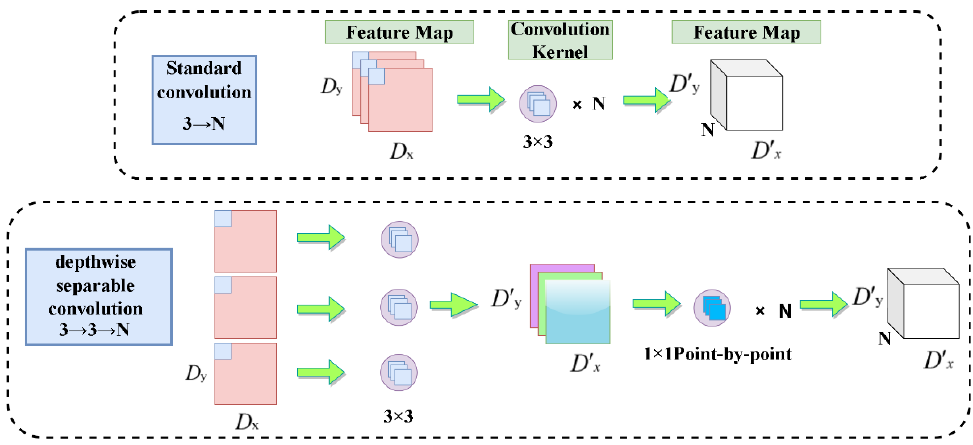
Figure 5. Comparison of standard convolution and depth-separable